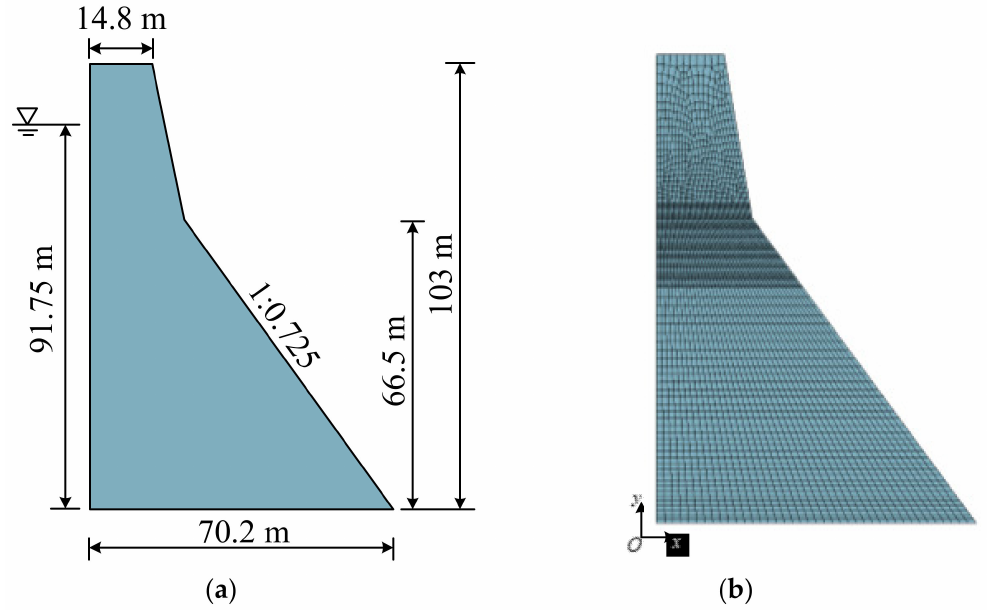
Figure 17. The Koyna dam: ( a ) geometry and dimensions and ( b ) finite element